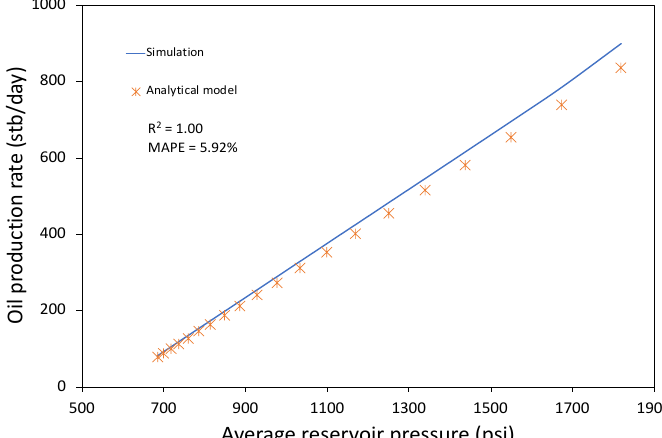
Figure 5. Comparison between the model-predicted production rate and the simulation results (Case 2).